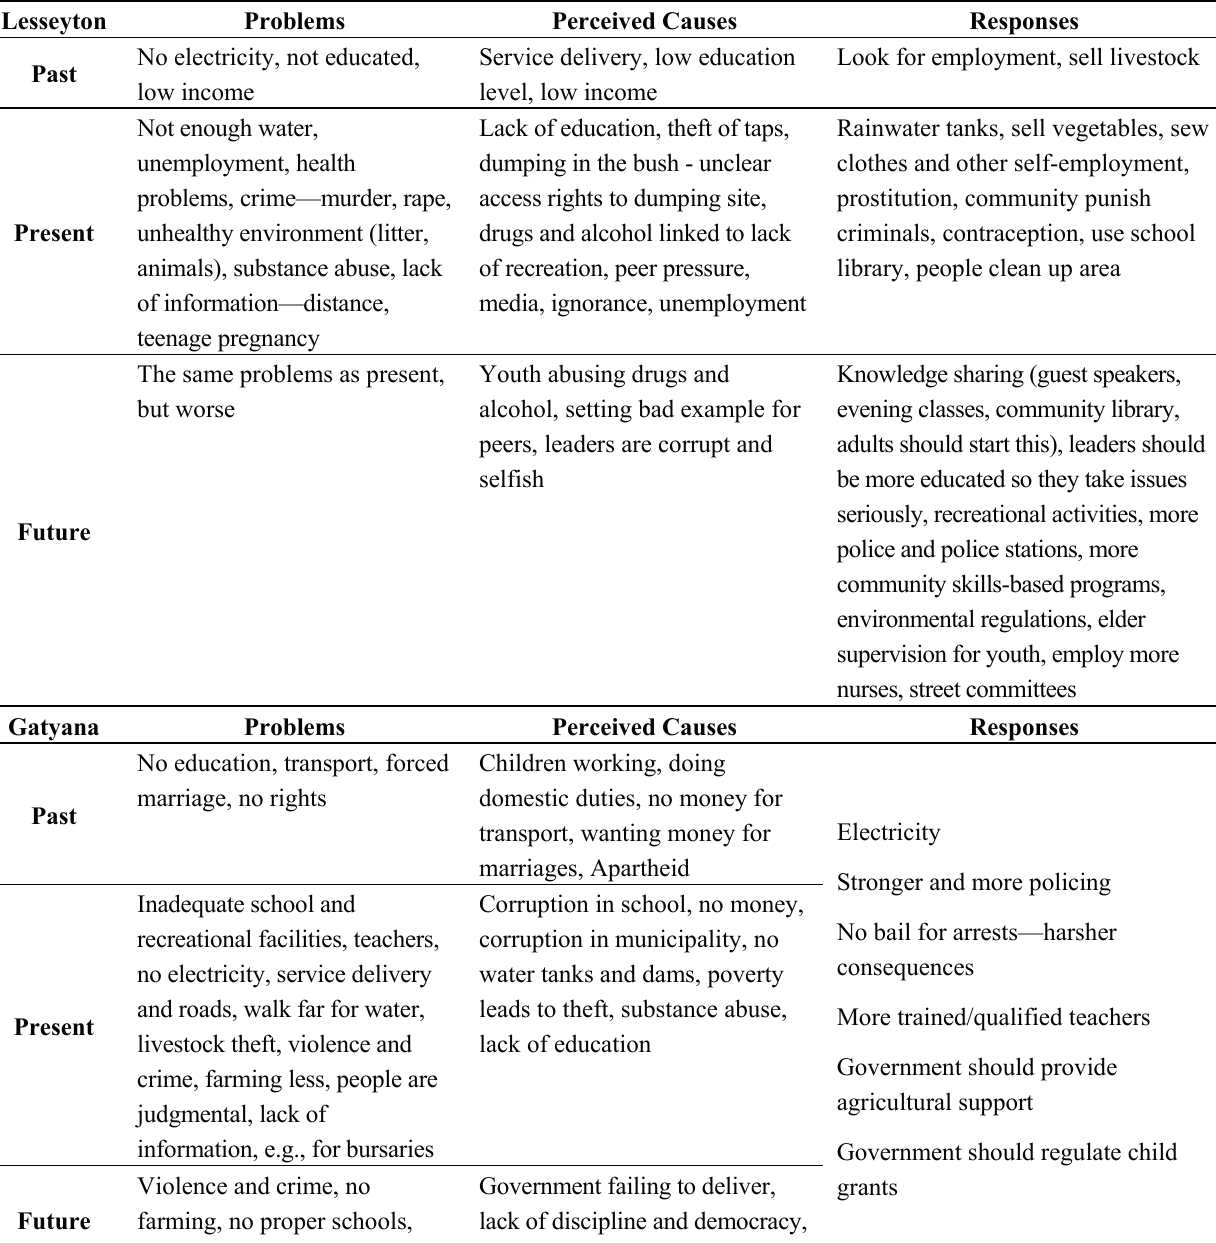
Table 5. Past, present and future problems and path dependency as discussed by the youth (Grade 11 learners) in Lesseyton and Gatyana (n =